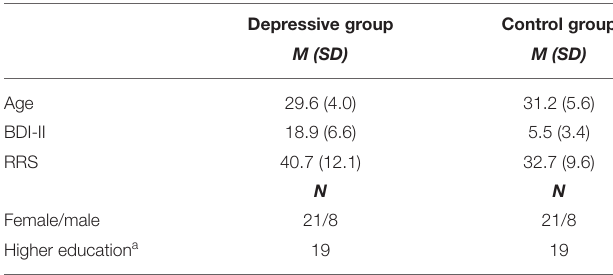
TABLE 2 | Participant characteristics study